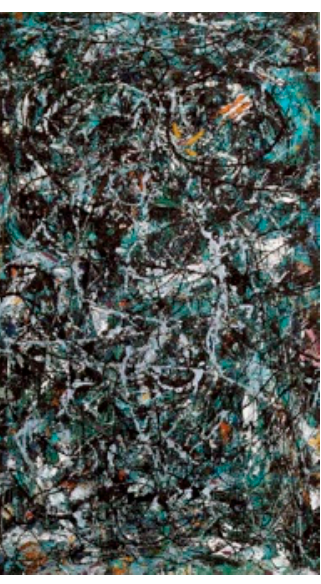
Figure 18. Jackson Pollock, Full Fathom Five , 1947. Oil on canvas with nails, tacks, buttons, key, coins, cigarettes, matches, etc., 50 7/8 × 30 1/8 in. (129.2 × 76.5 cm). Collection Museum of Modern Art, New York. Gift of Peggy Guggenheim, 1952. © 2022 The Pollock-Krasner Foundation/Artists Rights Society (ARS), New York.